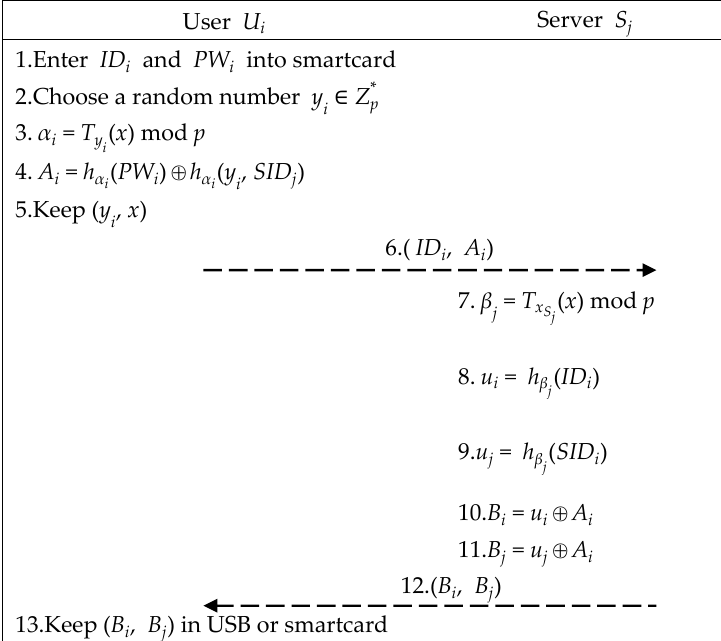
Figure 3. Registration phase of the proposed scheme.